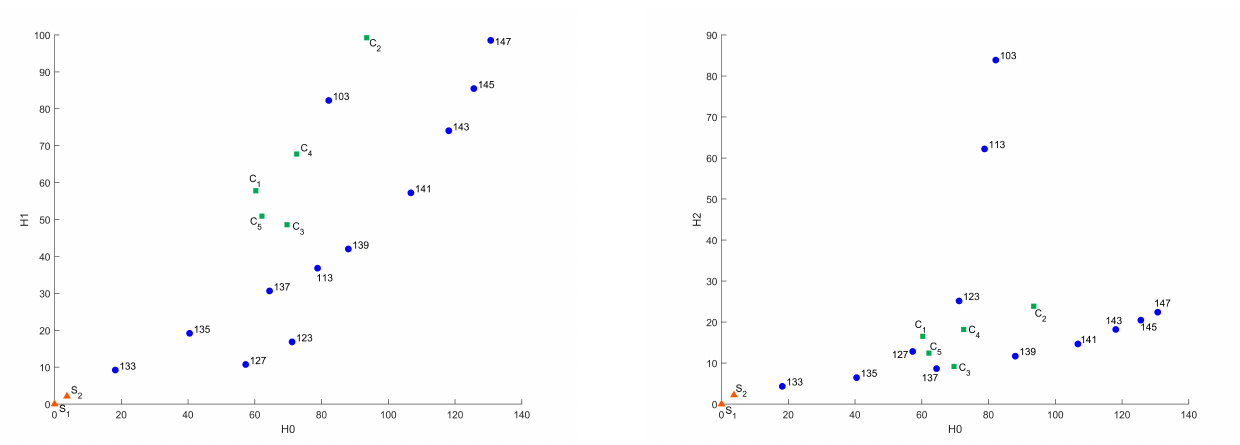
Figure 10. Influence of the binarization threshold of A sample in Heat Kernel metric in 3D and H 1 – H 2 coordinates.